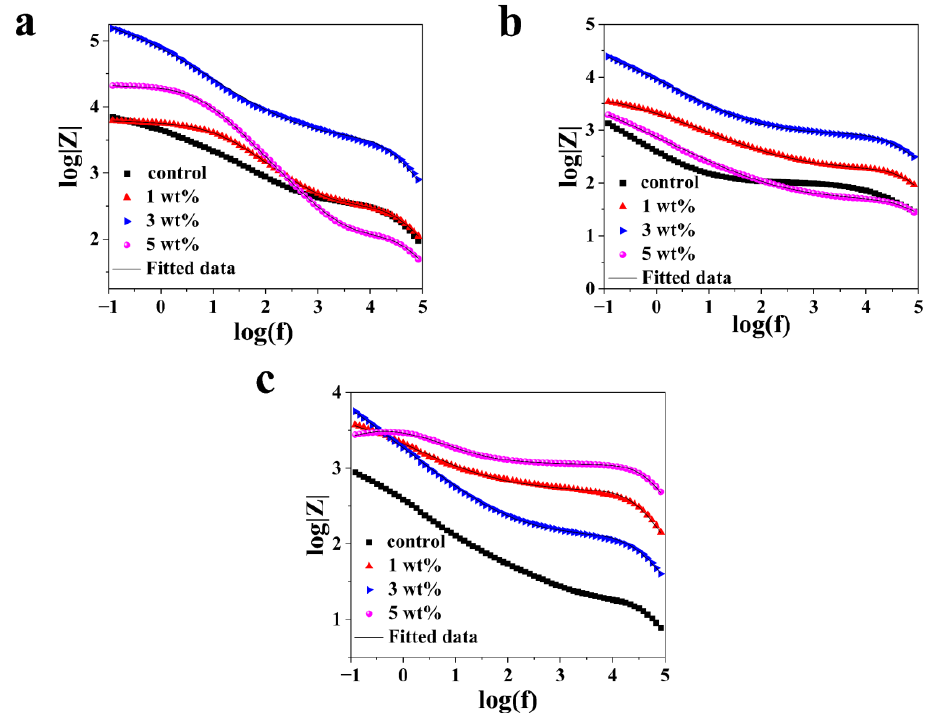
Figure 12. Bode plots of different coatings immersed in 3.5 wt% NaCl solution for ( a ) 48 h, ( b ) 144 h, and ( c ) 840 h.